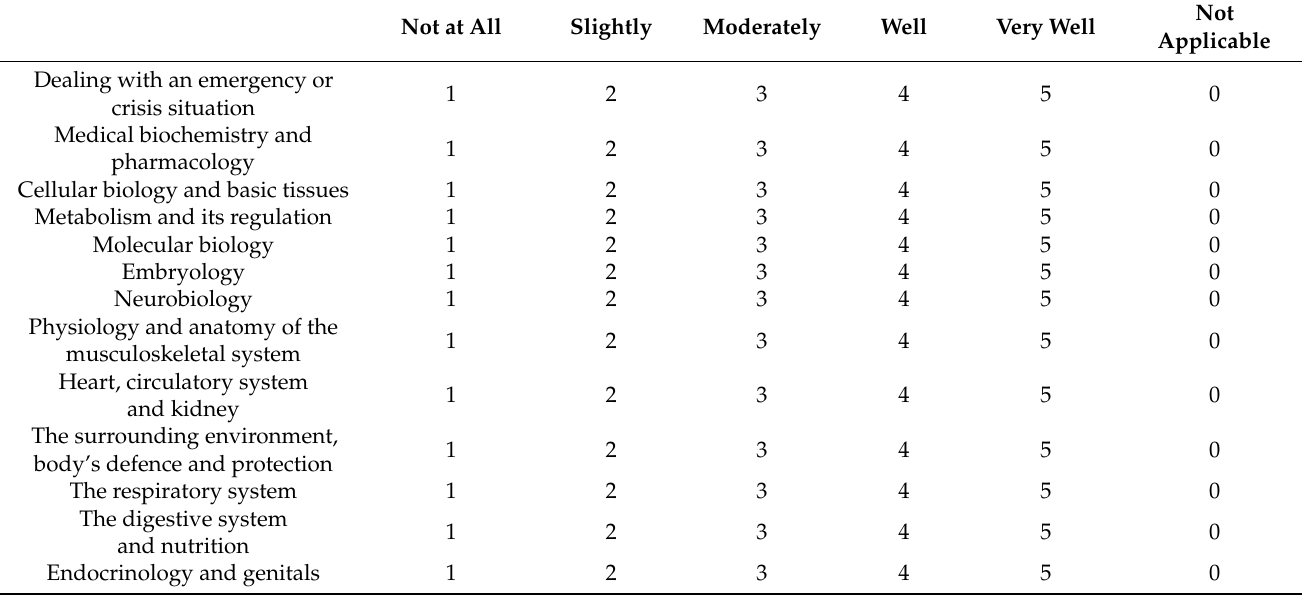
Table A2. I Preclinical studies. Evaluate how the study courses of the first two study years have formed basis for the clinical phase studies. Circle the option “Not applicable” if you have not attended to the study course.